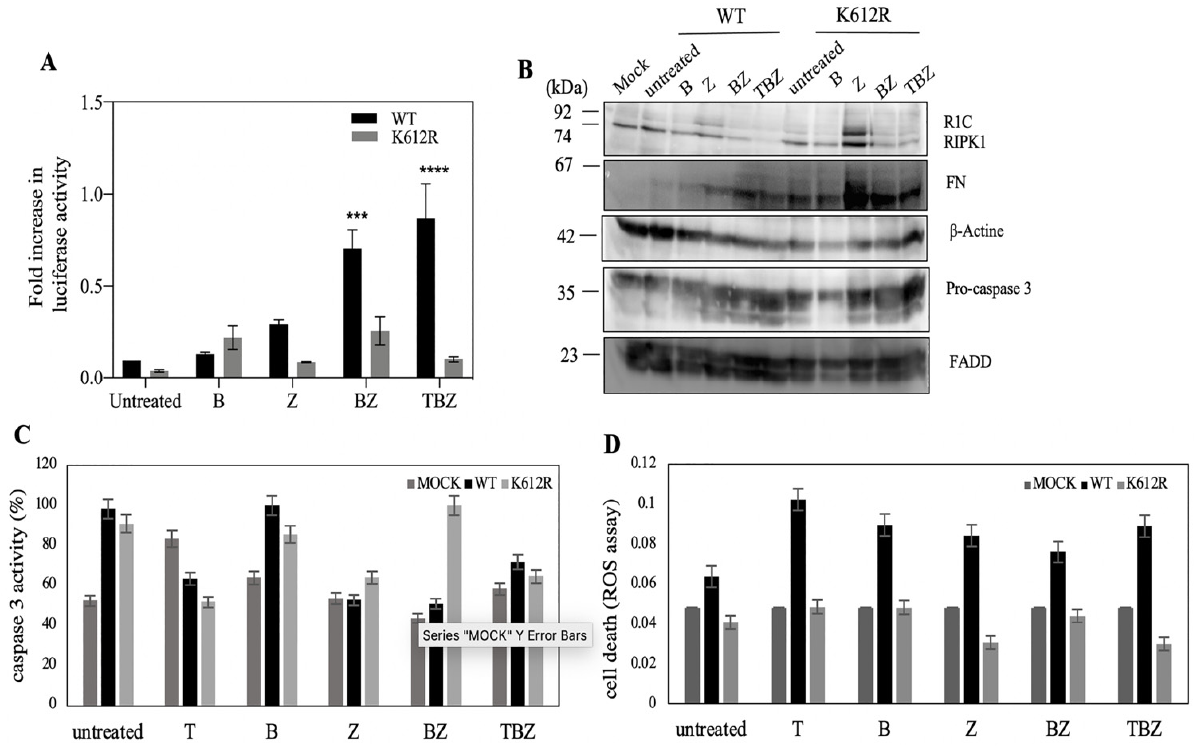
Figure 3. RIPK1 K612R revealed reducing luciferase activity compared to WT RIPK1. Co-transfected SHSY5Y cells with WT/RIPK1 K612R and FADD were pretreated with BV6 (5 µ M) and zVAD.fmk (25 µ M), and then with TNF α (100 ng/mL) for 18 h. ( A ) Luciferase activity as indicator of protein complementation; *** p ≤ 0.001; **** p ≤ 0.0001. ( B ) western blot of expressed proteins; ( C ) caspase-3 activity with Ac-DEVD-AMC substrate and ( D ) cell death was measured by ROS assay. Data are presented as mean ± SE; n = 3 of biologically independent samples. Two-way ANOVA with Bonferroni’s multiple comparison test.